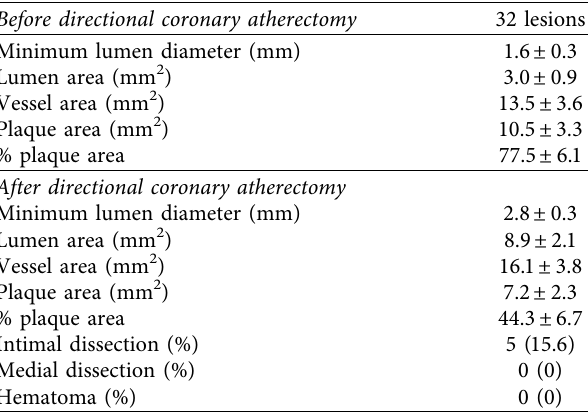
Table 4: Intravascular ultrasound findings.